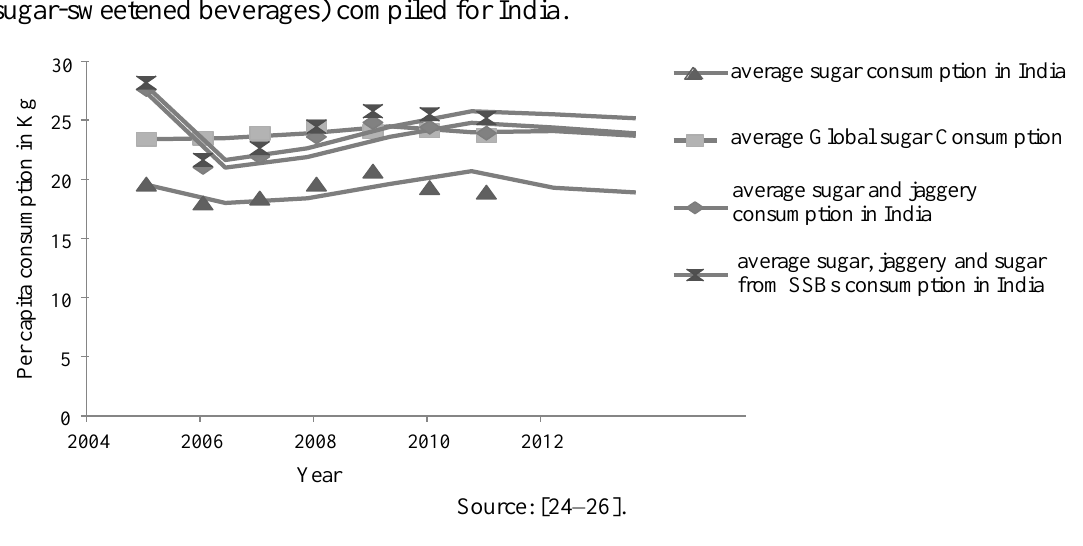
Figure 3. Trend line showing average intake of sugar globally and total sugar intake from various sources (“traditional sugars”: jaggery and khandsari ; sugar and sugar from sugar-sweetened beverages) compiled for